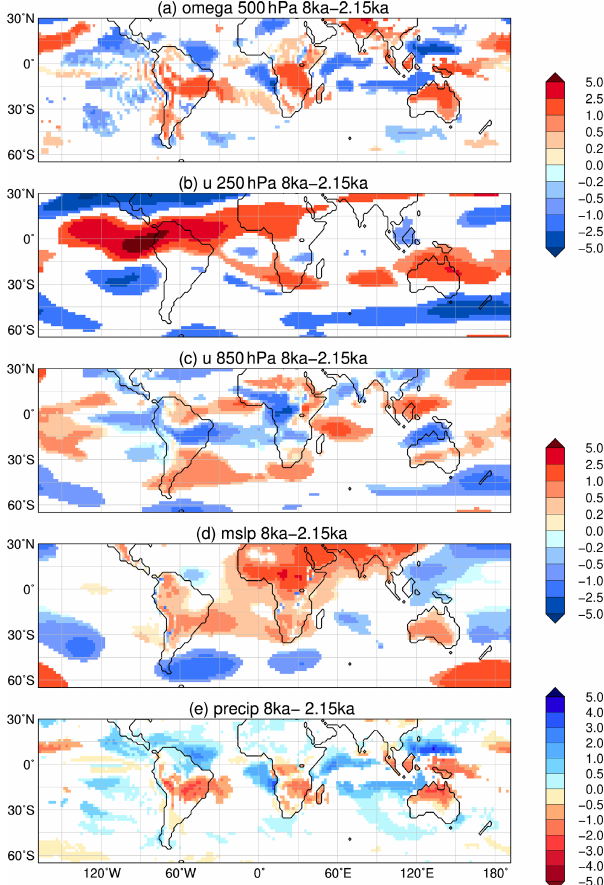
Figure 8. Simulated difference in June to August (JJA) mean cli- mate in the model for the time slice 8ka compared to 2.15ka, i.e. (a) vertical velocity (omega) in 500hPa (10 − 2 ms − 1 ) with blue colour showing increased uplift during 8ka; (b) upper-tropospheric zonal wind ( u ) in 250hPa (ms − 1 ) with blue colours indicating enhanced easterly wind; (c) low-level zonal flow ( u ) in 850hPa (ms − 1 ); (d) zonal anomaly in lower-tropospheric streamfunction (psi*, in 10 7 m 2 s − 1 ) reflecting the change in standing waves, with blue colours indicating increased cyclonic circulation at 8ka com- pared to 2.15ka; and (e) mean seasonal precipitation (mmd − 1 ) with blue colours showing enhanced precipitation during 8ka. Only sig- nificant changes are shown ( t test, 99% confidence interval).